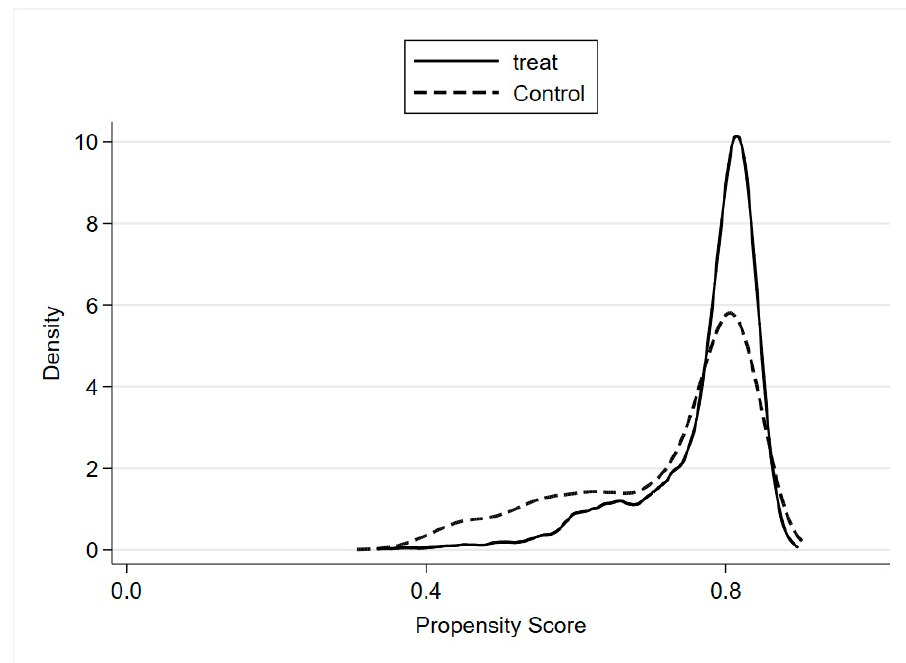
Figure 3. Density distribution of the propensity score (before matching).